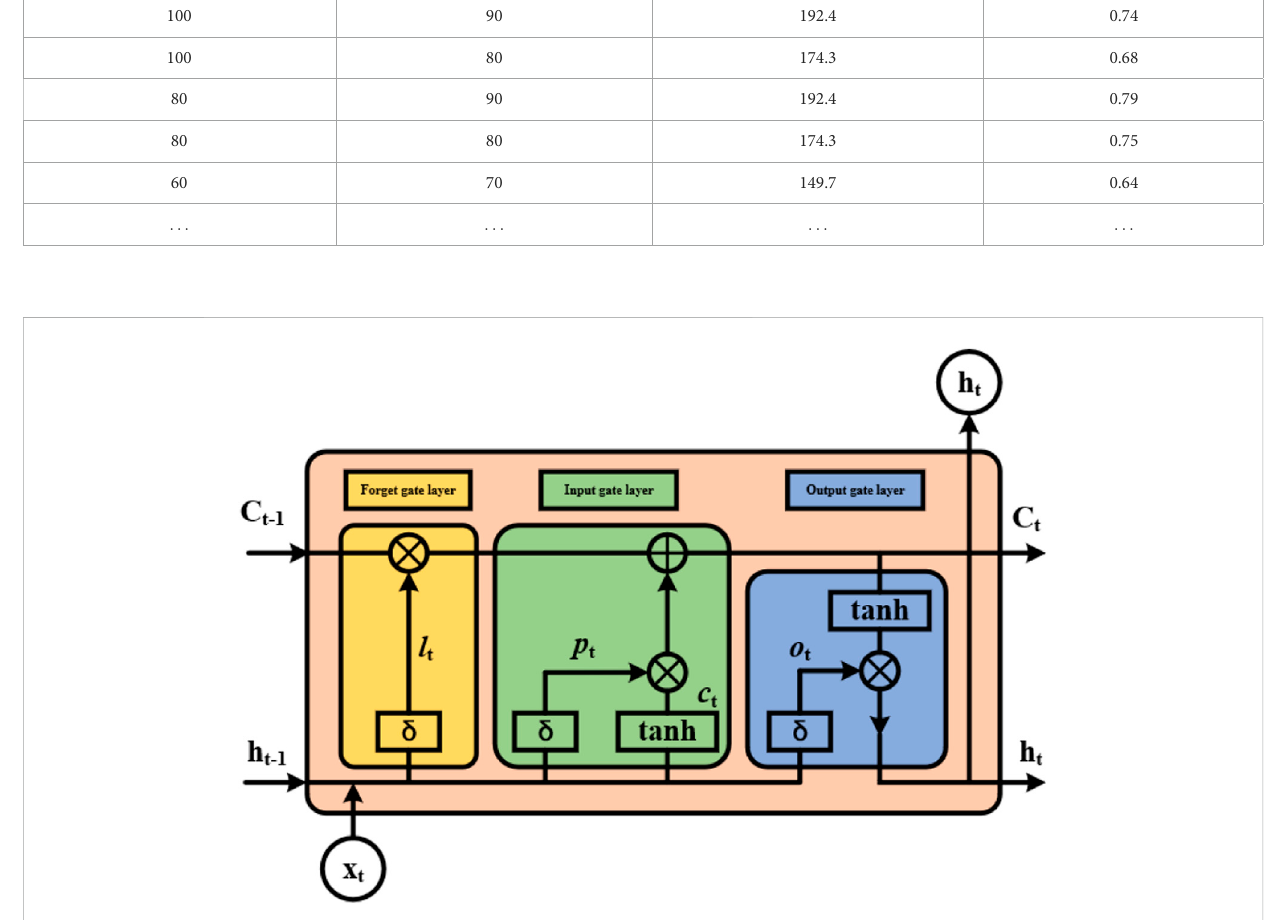
FIGURE 4 LSTM neural network